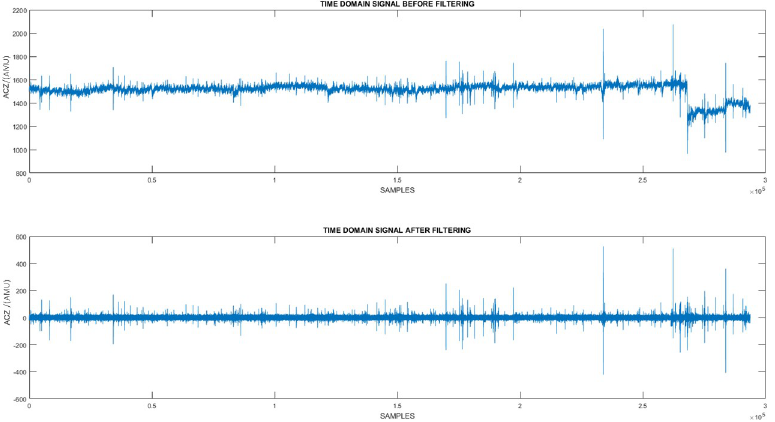
Fig 7. The raw time domain data captured from the sensor vs the time domain data when a custom high pass filter was applied. In this figure a comparison between the filtered and non filtered time domain data can be made. The Z-Axis acceleration data of a single session is used for the comparison. In the non filtered signal significant shifts in the time domain signal can be observed. However, they are eliminated when the high pass filter was implemented.